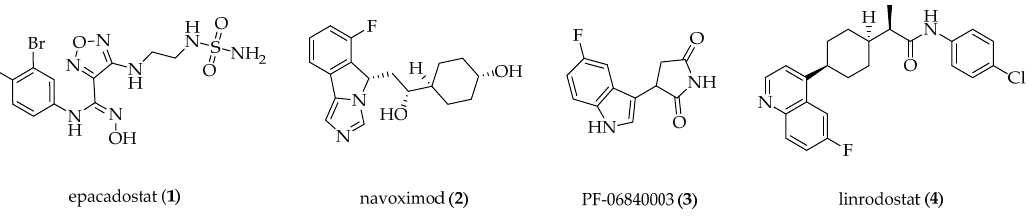
Figure 1. Structures of representative IDO1 inhibitors.